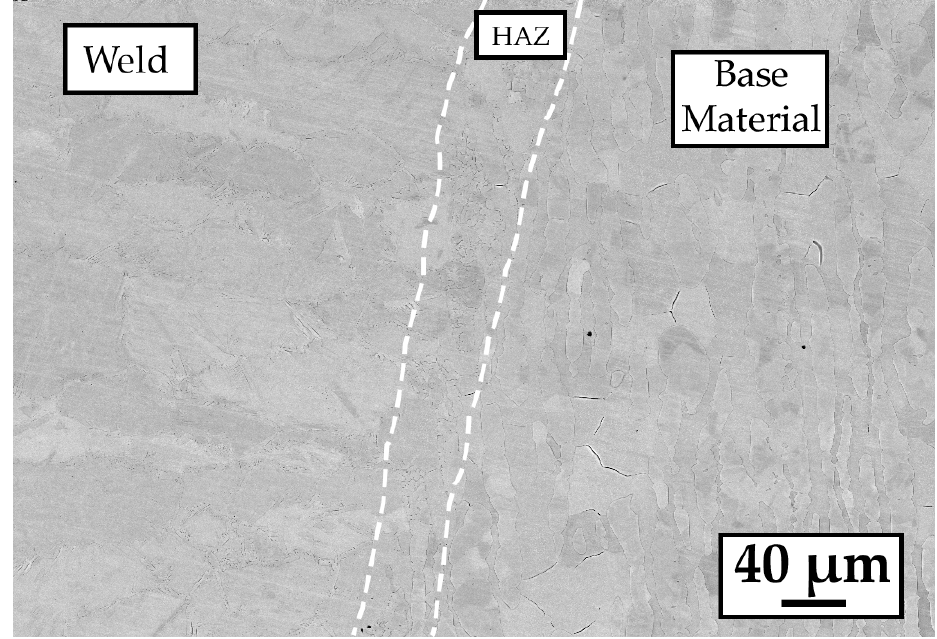
Figure 4. Back-scattered electron micrograph of the HAZ region (center), the weld bead (left) and the base metal (right).